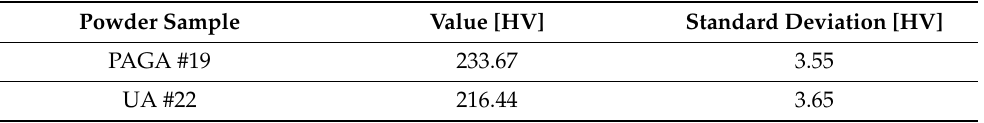
Table 6. Hardness measurements of samples obtained using PAGA and UA powders (#19 and #22 are process parameters from Table